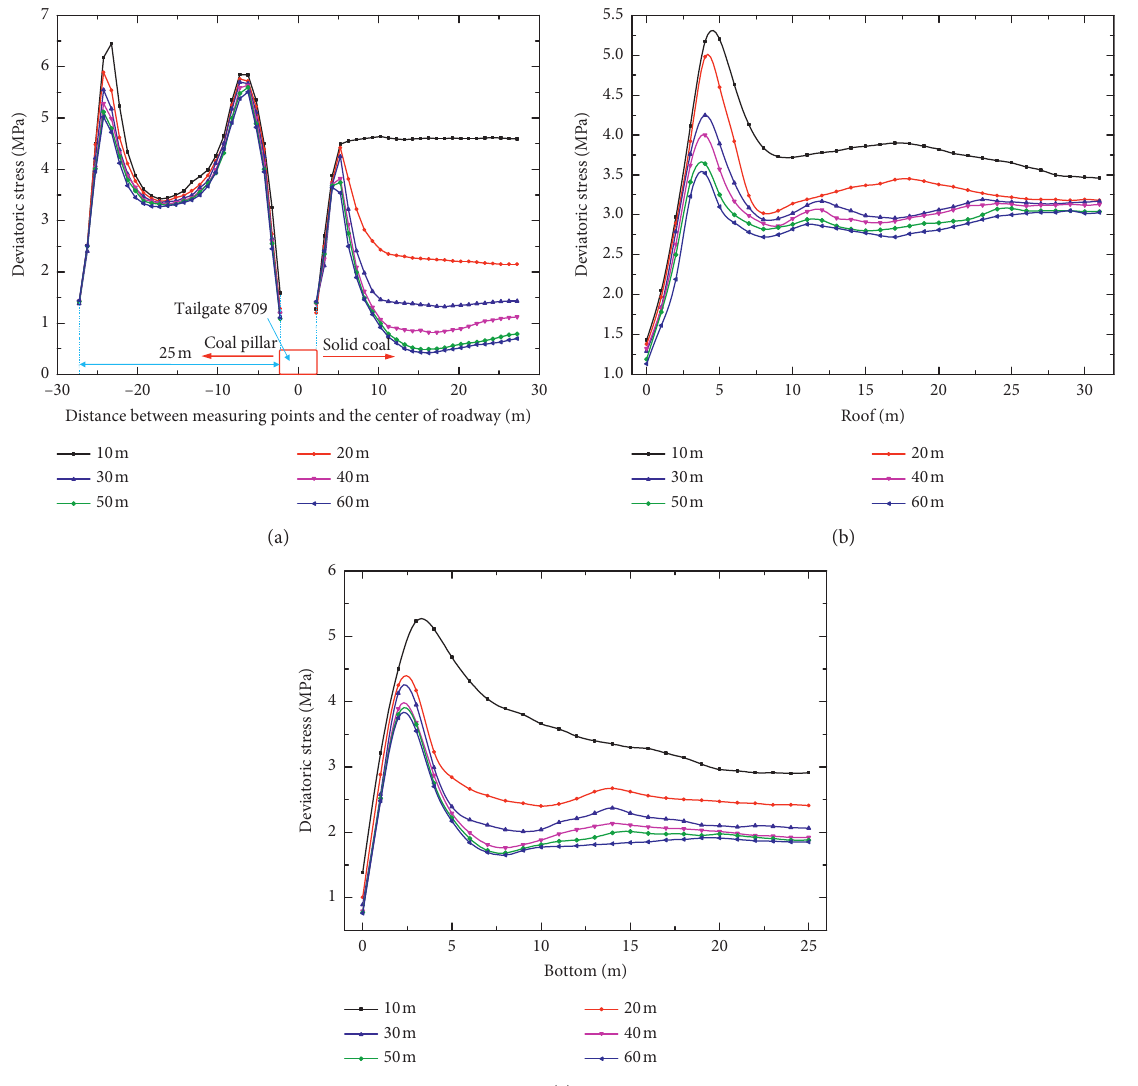
Figure 9: Deviatoric stress curves of Tailgate 8709 in the mining process of the N8707 coal face in No. 11 coal seam: (a) deviatoric stress curves in coal pillar and solid-coal side; (b) deviatoric stress curves of the roof; (c) deviatoric stress curves of the